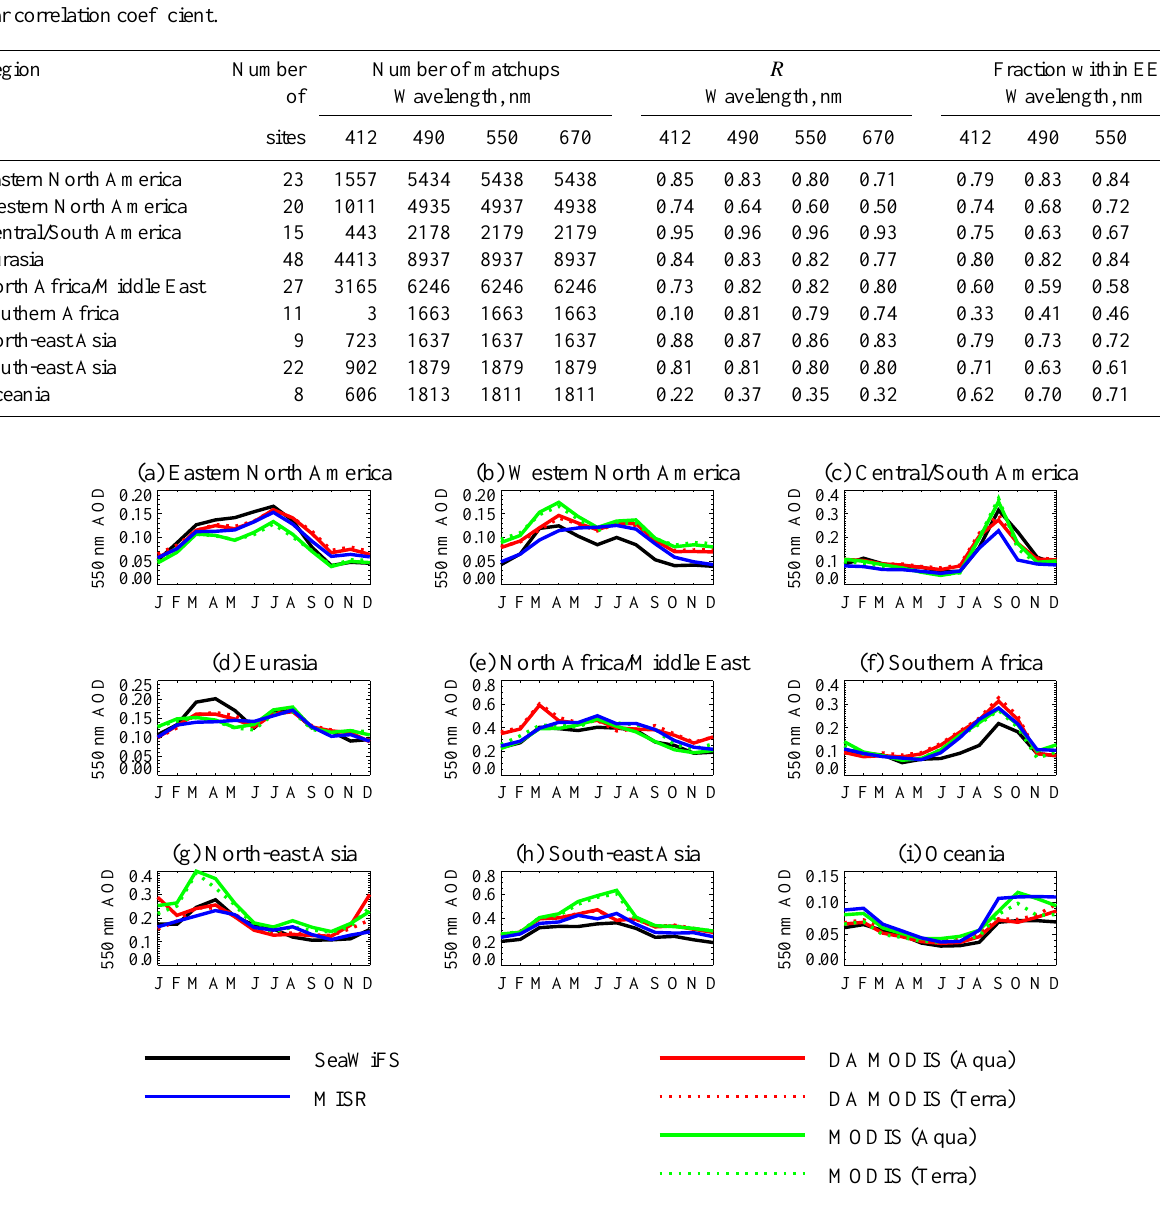
Fig. 9. Annual cycles of 550nm AOD from the satellite datasets, for each region. Month names are abbreviated using their first letters, in order